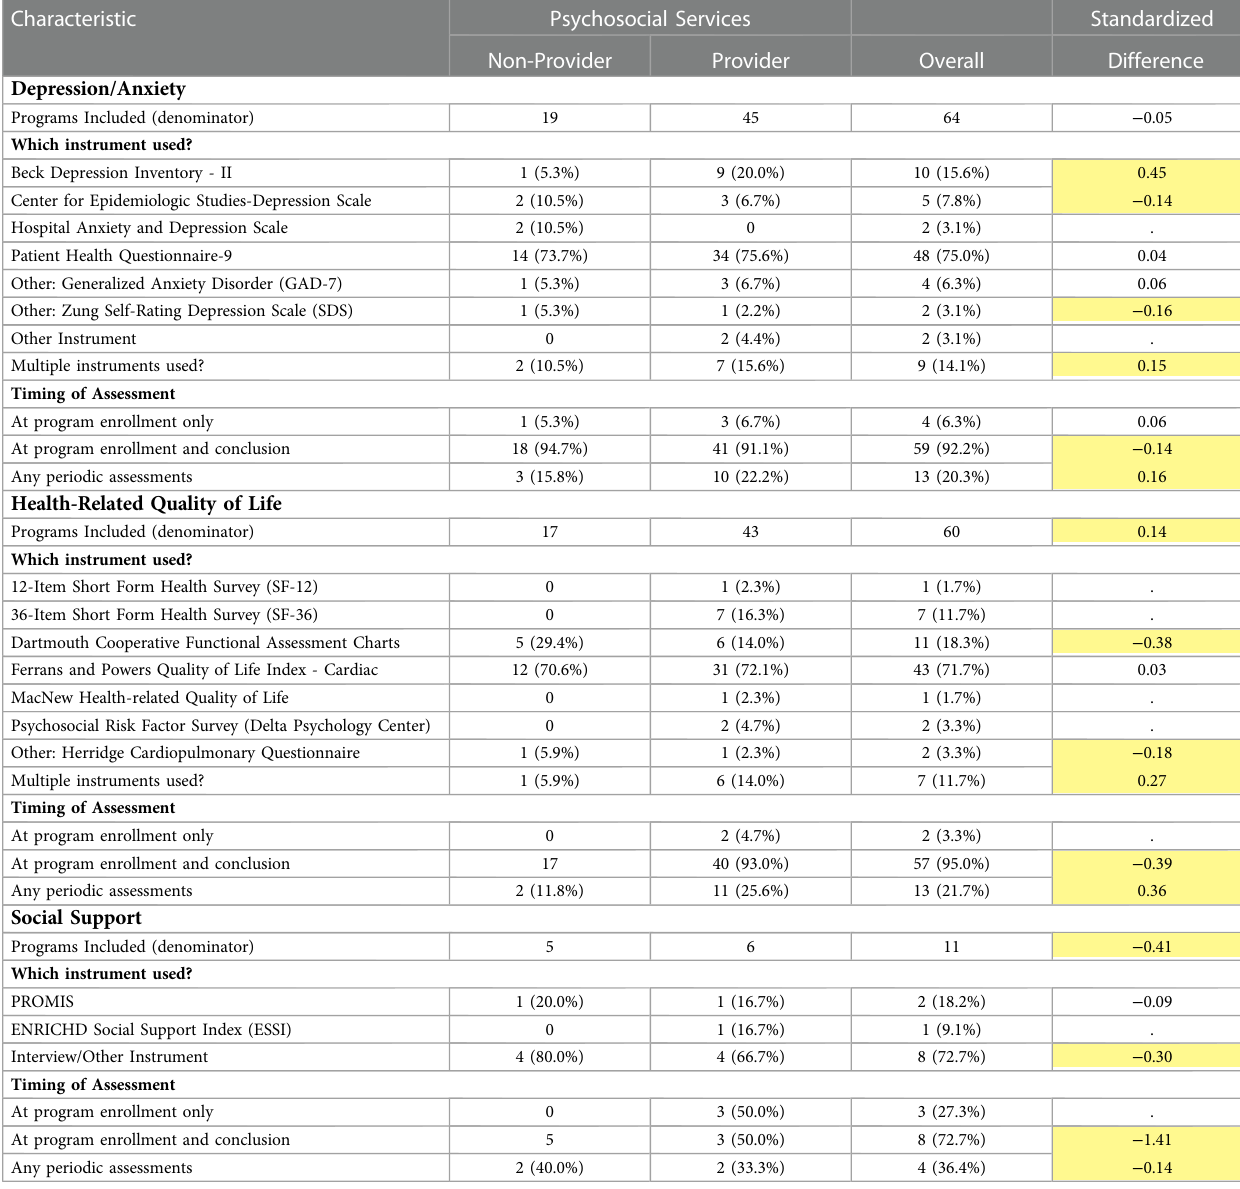
TABLE 2 Summary of psychosocial assessments performed at outpatient cardiac rehabilitation programs .